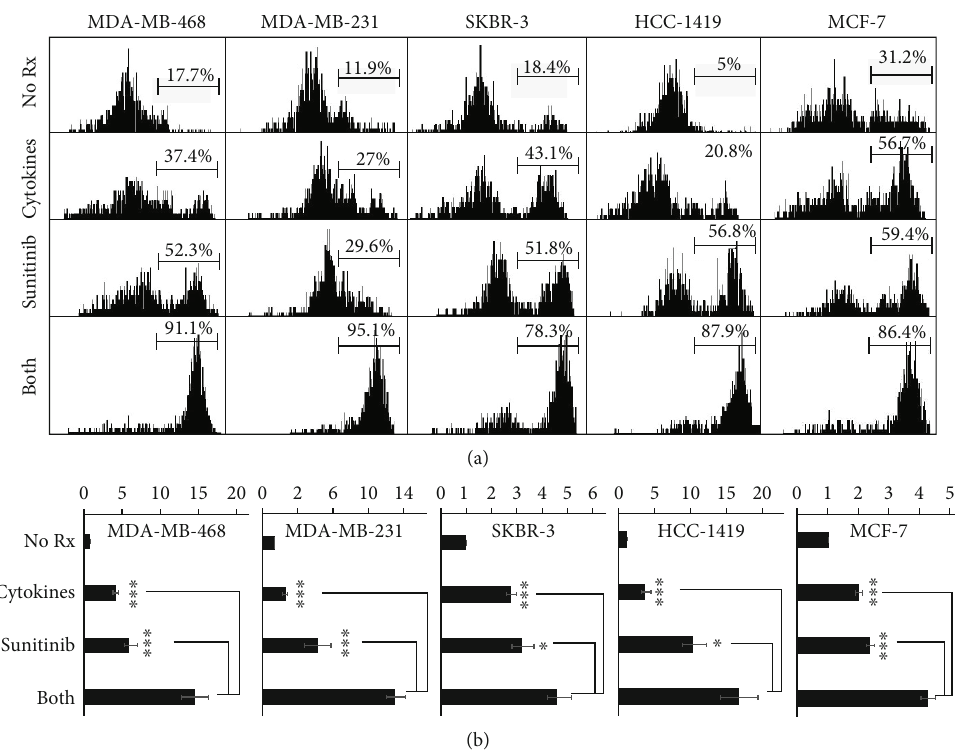
Figure 2: Trypan Blue retention maximized by dual treatment with sunitinib and Th1 cytokines. MDA-MB-468, MDA-MB-231, SKBR-3, HCC-1419, and MCF-7 cells were seeded at 5 × 10 4 per mL and were left either untreated (No Rx) or treated with Th1 cytokines (5 ng/mL), sunitinib (10 μ M), or sunitinib and Th1 cytokines (both) for 72 hours. Cells were harvested and stained with Trypan Blue dye, after which dye uptake was detected via its fl uorescent properties via fl ow cytometry using a 642 nm excitation laser. (a) Histogram analysis of representative experiment for each cell line. The gated region represents the percentage of Trypan Blue-retaining (dead) cells. (b) Data represent the summary analysis of mean channel fl uorescent index of treated, stained cells from at least three separate experiments per cell line. Statistical signi fi cance was determined by one-way ANOVA: MDA-MB-231 ( F ð 3, 56 Þ = 46 : 1 , p < 0 : 001 ), MDA-MB-468 ( F ð 3, 52 Þ = 33 : 1 , p < 0 : 001 ), MCF-7 ( F ð 3, 28 Þ = 91 : 5 , p < 0 : 001 ), HCC-1419 ( F ð 3, 28 Þ = 19 : 1 , p < 0 : 001 ), and SKBR-3 ( F ð 3, 24 Þ = 22 : 4 , p < 0 : 001 ), followed by the post hoc Tukey test. Error bars represent the standard error of the